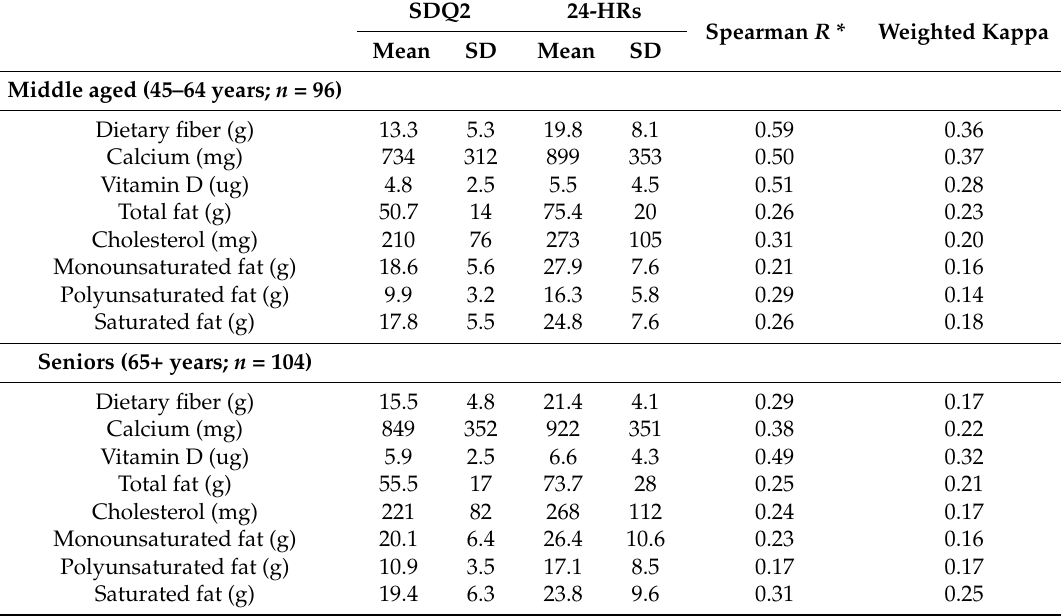
Monounsaturated fat